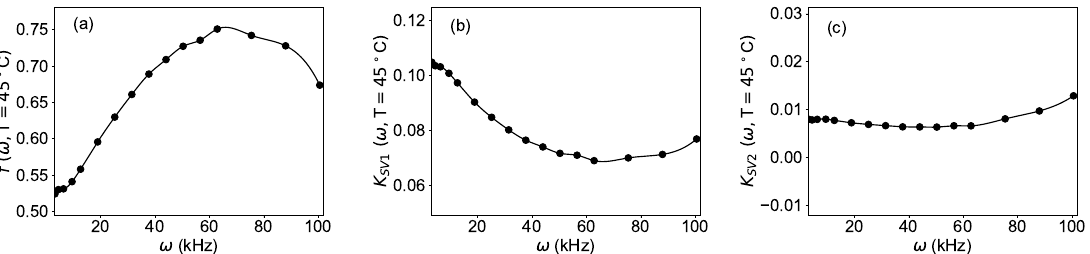
Figure 5. Dependence of the parameters of Equation (4) from the angular frequency of the modulation: ( a ) f ( ω , T ) , ( b ) K SV 1 , ( c ) K SV 2 . Dots: result of the fit of the experimental data; solid line: spline approximation used to generate the synthetic